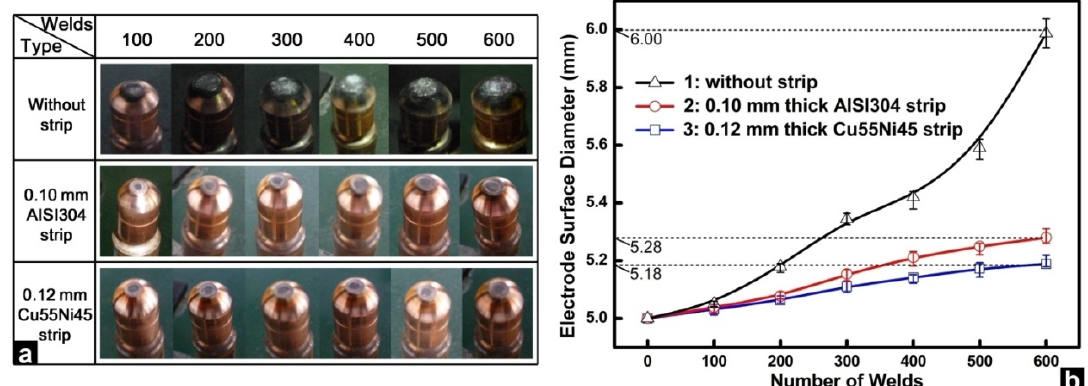
Figure 15. Comparison of ( a ) electrode surface profiles and ( b ) electrode surface diameter during electrode wear test [4]. Reprinted with permission.